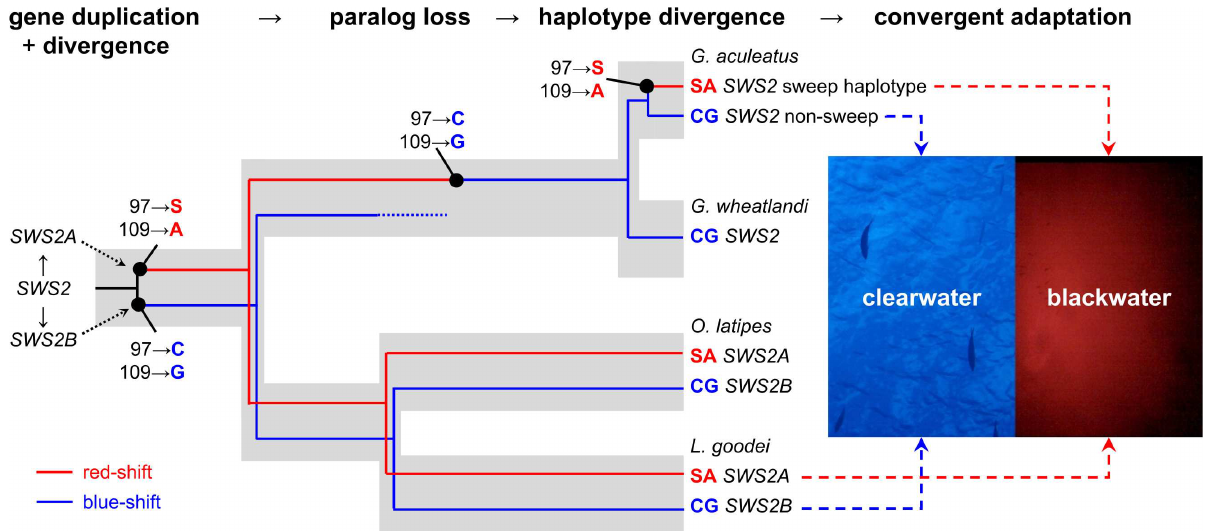
Fig 8. Convergent evolution of the blue-sensitive SWS2 opsin at the molecular, functional, and ecological level. The duplication of SWS2 in the ancestor of most spiny-rayedfish 198 million years ago was followedby a red-shift in SWS2A and a blue-shift in SWS2B [22, 47], paralogsthat are divergently expressedamongbluefin killifish ( L . goodei )living in blackwater and clearwaterhabitats [24]. Two key amino acid polymorphisms of the ancientparalogscausingshifts in their absorptionspectra have reevolvedwithin threespine stickleback and are now divergentlyselectedbetweenblackwaterand clearwaterhabitats in HaidaGwaii—convergentevolutionat the molecular, functional, and ecological level. Clearwater spectra (left photo) are blue-shifted with increasingdepth, typical of marine habitats and oligotrophicclearwater lakes on HaidaGwaii [18]. Tannin-stainedblackwater (right photo) absorbs almost all up- and sidewelling light, making it a nearly nocturnal habitat, except for red-shifted downwellinglight visiblein a small cone above the observer. Uneditedphotos taken with a GoPro Hero 4 (GoPro Inc.) pointedtowards the zenith at approximately 20 m depth in clearwater(Palau) and at 4 m depth in blackwater (Drizzle Lake).